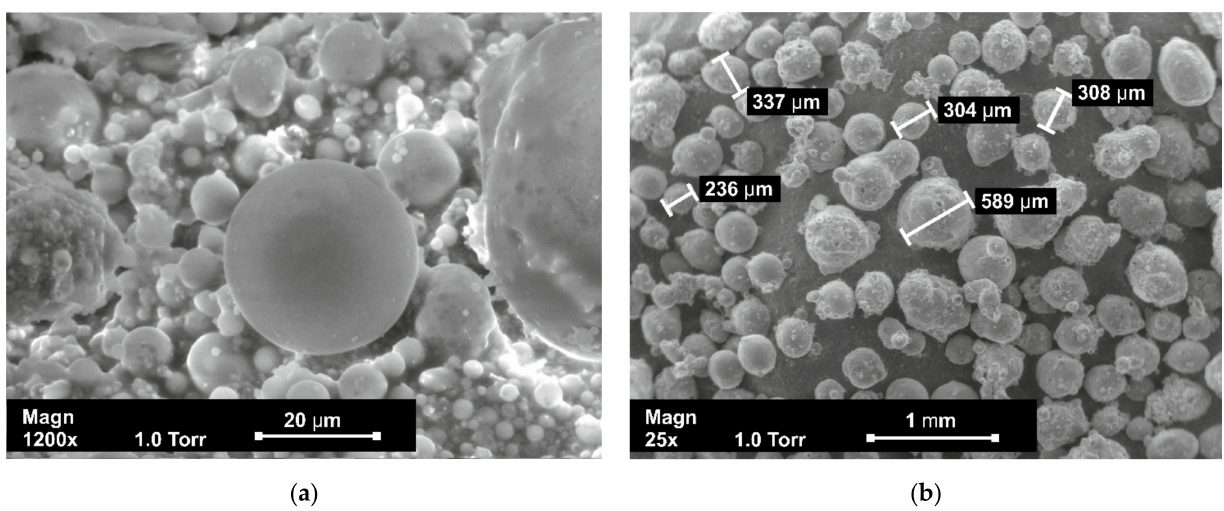
Figure 1. SEM, microscopic images: ( a ) up to 200 µ m; ( b ) up to 500 µ m of grain sizes of the FAMs. The visible shape of the microspheres, depending on the size of the particle fractions is diverse; from almost perfectly spherical to highly irregular (Figure 1).